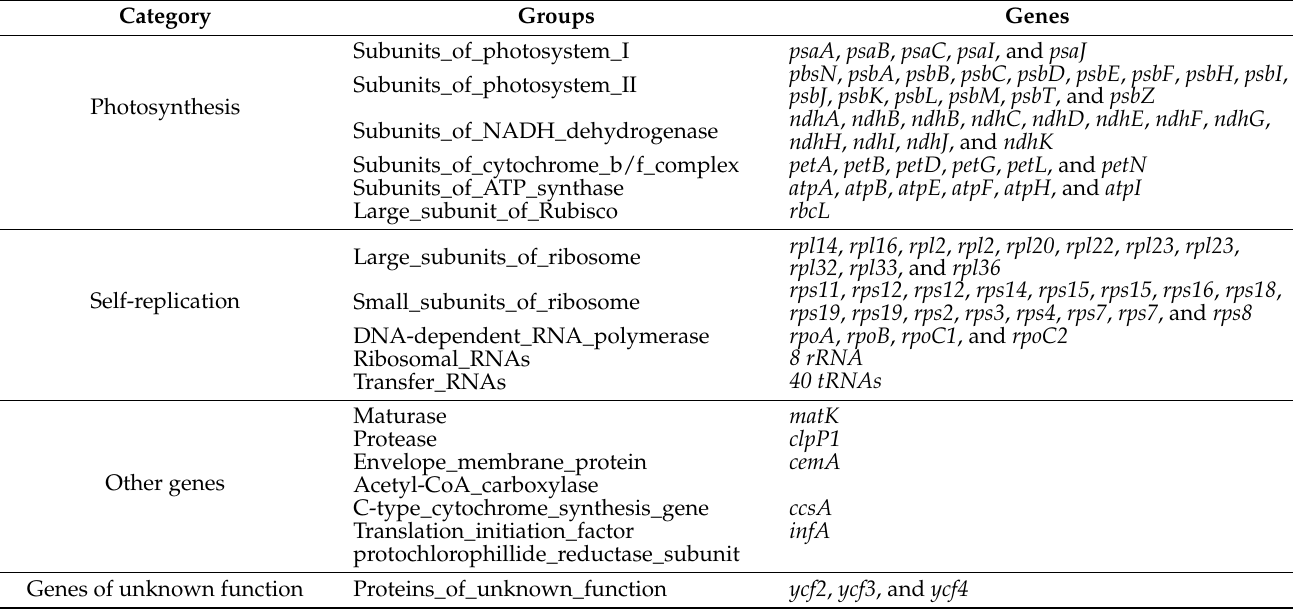
Table 4. Genes encoded by three species of Echinochloa chloroplast genome.